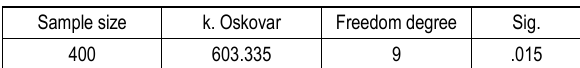
Table 21. Results of Friedman test (factors of